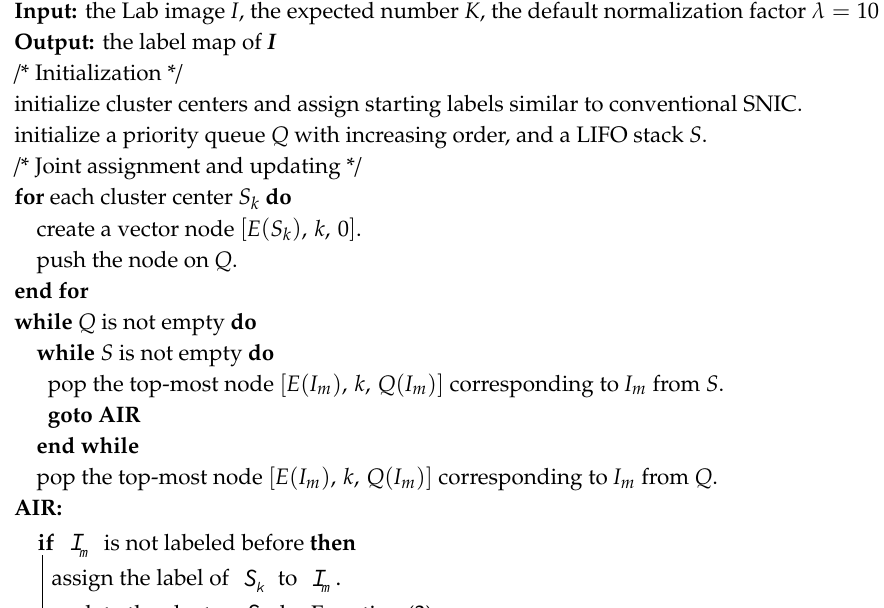
Algorithm 1 NICE superpixel segmentation framework